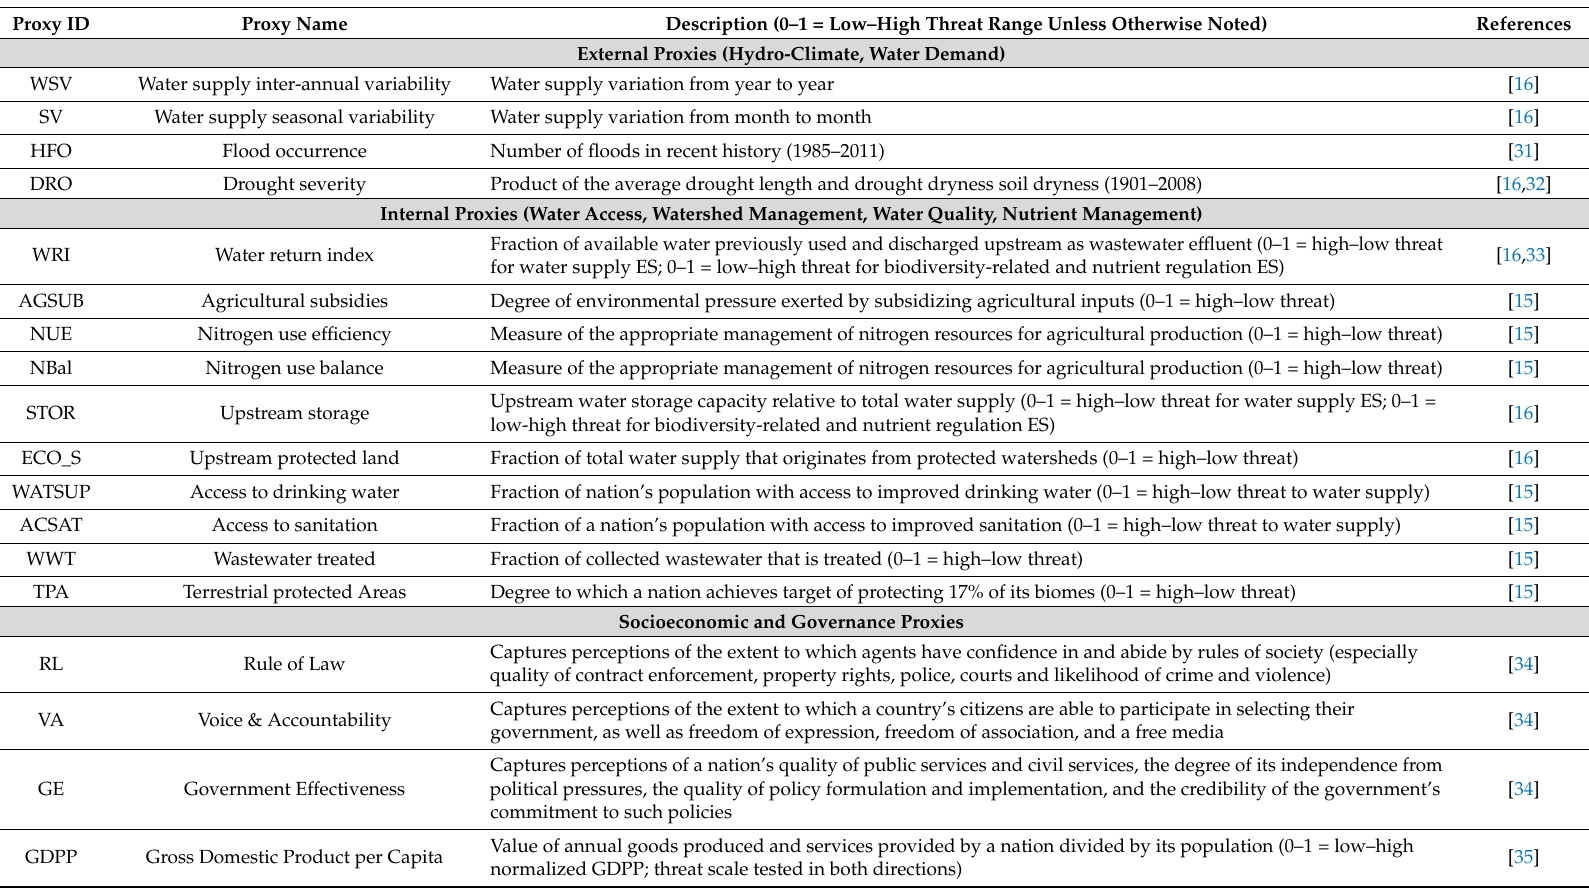
Table 2. Environmental and demographic indicators tested as proxies for aquatic ecosystem service threat